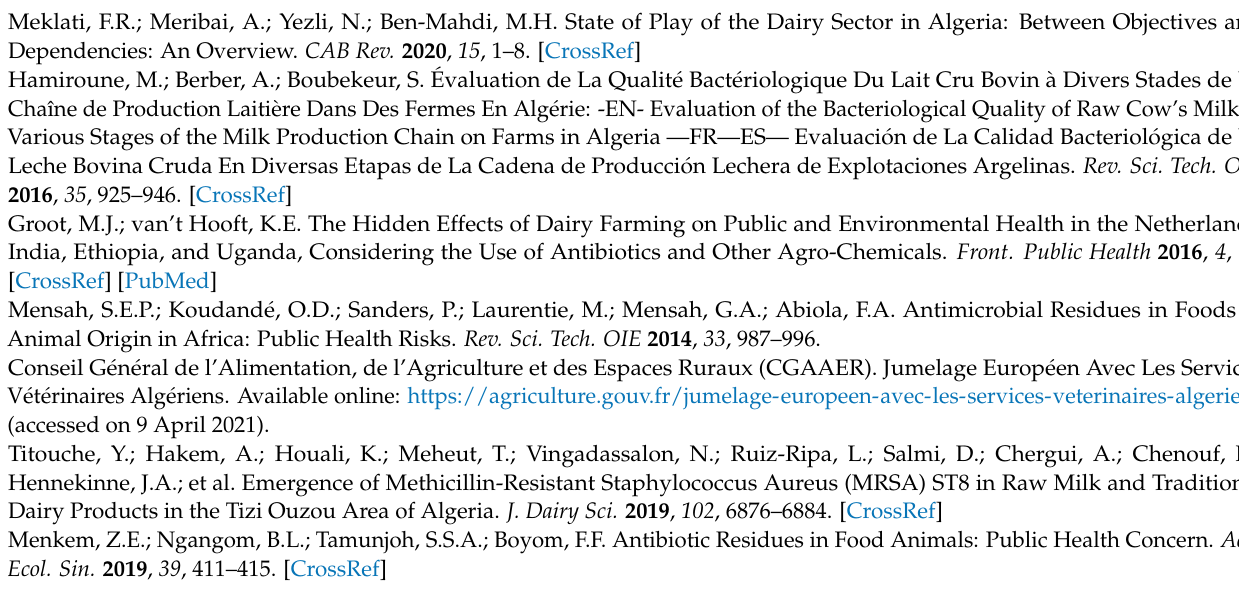
Table S2: Gradient elution programs for the determination of antibiotic residues, Table S3: MRM parameters and retention times for all compounds determined, Table S4: Sensitivity and specificity of BetaStar ® Combo test regarding to LC-MS/MS for β -lactams, Table S5: Sensitivity and specificity of BetaStar ® Combo test regarding to LC-MS/MS for tetracycline, Table S6: Experimental results by individual code for each milk sample analyzed by LC-MS/MS, Table S7: Relationship between variables (FL, acidity, and samples origin) and the results of screening using BetaStar ® Combo and LC-MS/MS, Table S8: Comparison of FL (g/100 mL) and titratable acidity ( ◦ D) means following the BetaStar ® Combo test result, Table S9: Variance of fat levels and acidity according to the accuracy of the rapid screening test for ß-lactams and